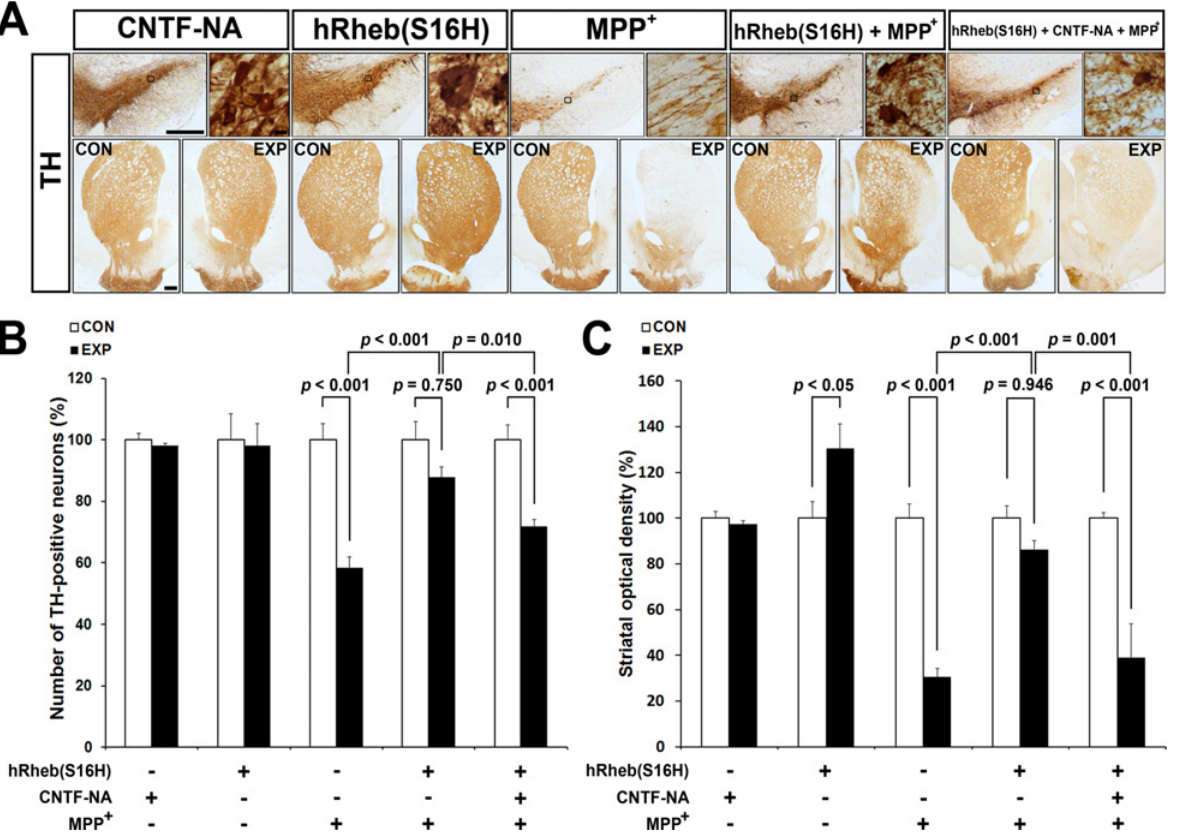
Fig 3. An increase in CNTF contributes to the hRheb(S16H)-induced neuroprotection of the nigrostriatal dopaminergic projection. (A) Rats received an intranigral injection of neutralizing antibodies for CNTF 3 weeks after AAV-hRheb(S16H) injection, and then they received an intra-MFB injection of MPP + 10 min after treatment with neutralizing antibodies. Representative coronal sections of TH immunoperoxidase staining showed that hRheb(S16H) transduction of dopaminergic neurons induced neurotrophic effects as previously described [12, 14], protected the nigrostriatal dopaminergic projection from MPP + -induced neurotoxicity. However, treatment with neutralizing antibodies for CNTF (CNTF-NA) attenuated the neuroprotective effects of hRheb(S16H)- induced neuroprotection. Neutralizing antibodies alone were not neurotoxic in normal brains. CON, contralateral control side; EXP, ipsilateral injected side. Scale bars, 500 μ m and 10 μ m in the SN, respectively, and 500 μ m in the STR. (B and C) The quantitative analysis of TH-positive neurons and fibers. Consistent with the immunostaining results, CNTF neutralization significantly inhibited hRheb(S16H)-induced neuroprotection in the MPP + -treated model of PD. All values are expressed as a percentage of the results in the ipsilateral SN and STR, respectively, compared with the contralateral controls (One-way ANOVA and Tukey post-hoc analysis; n = 4, each